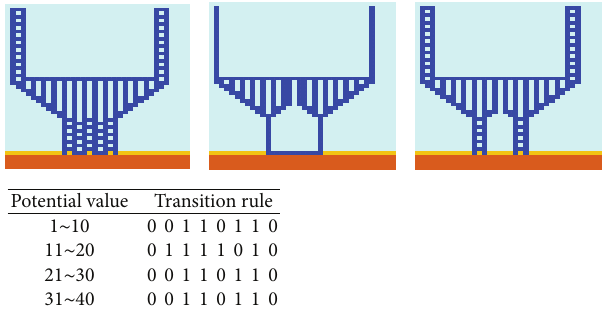
Figure 10: Result for variable initial conditions but the same transition rules. The initial conditions also caused slight changes in the shape of the structure under the same transition rules.